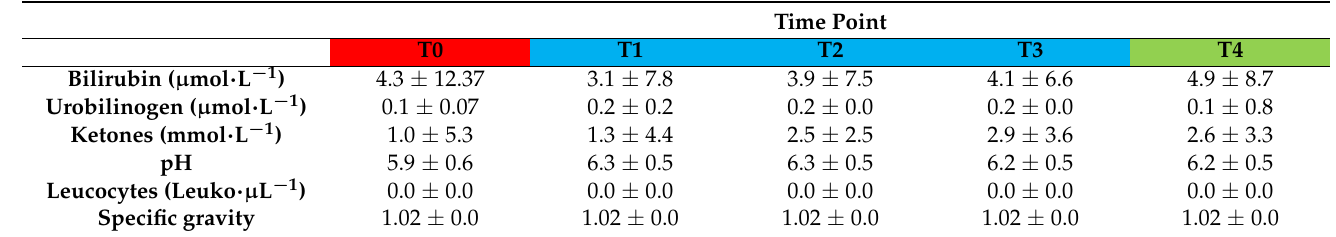
Table 3. Urine standard analysis. Urine test strip data values (mean ± SD) from all subjects. The colors of the time boxes (from T0 to T4), are the same as those reported in the histograms of figures from 2 to 4, to help the reader.